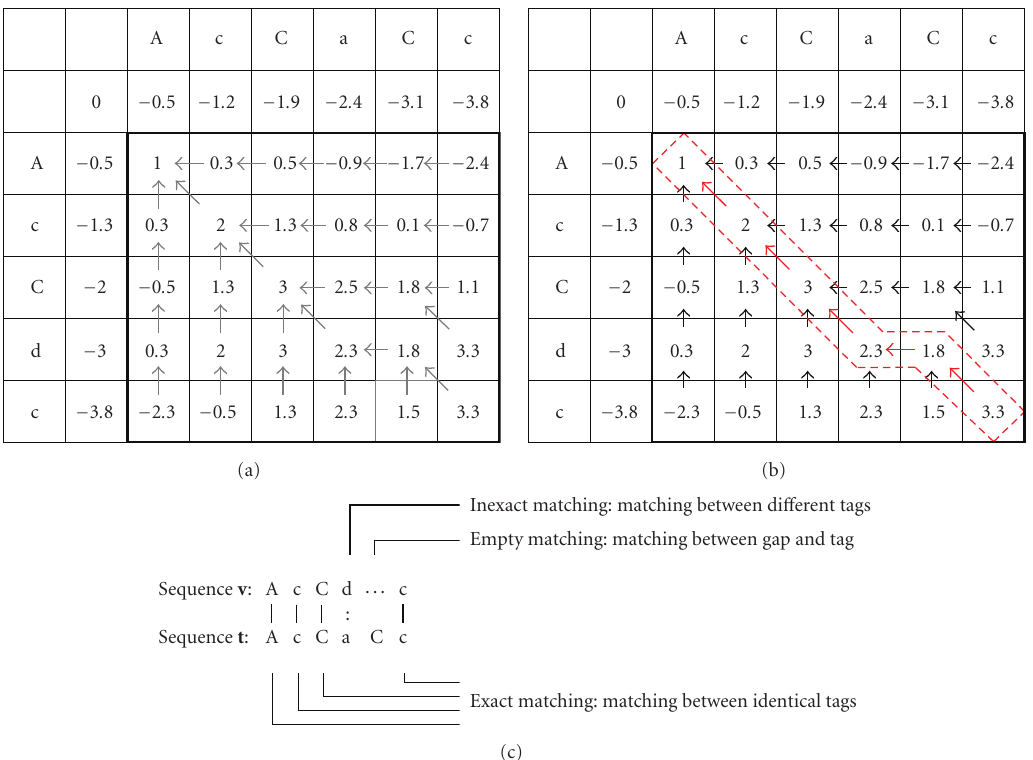
Figure 6: (a) Forward filling of score matrix and backtracking matrix, (b) backward tracing along best local alignment directories, and (c) sequence alignment